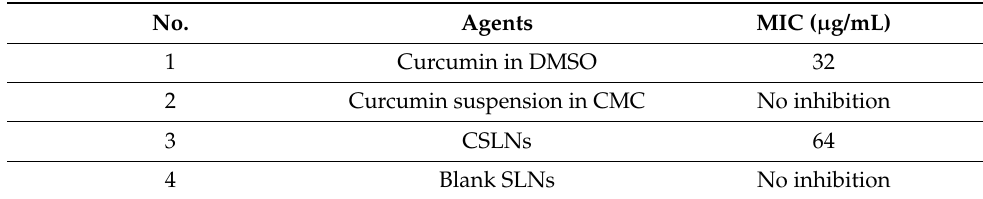
Table 10. Antimicrobial effect of CSLNs against Staphylococcus aureus ATCC 9144. No.